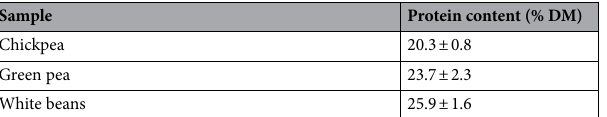
Table 2. Protein content of legume by-products (% dry matter, DM) determined by Kjeldahl method. All the samples showed a protein content above 20% on dry matter.